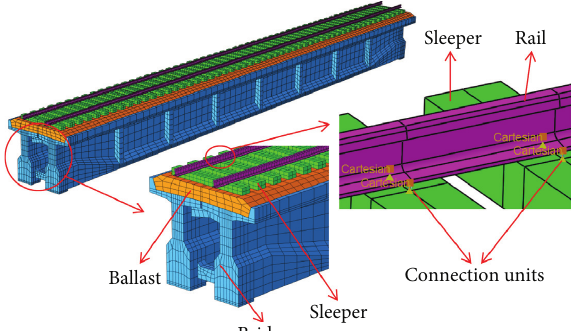
Figure 5: 3D FE model of